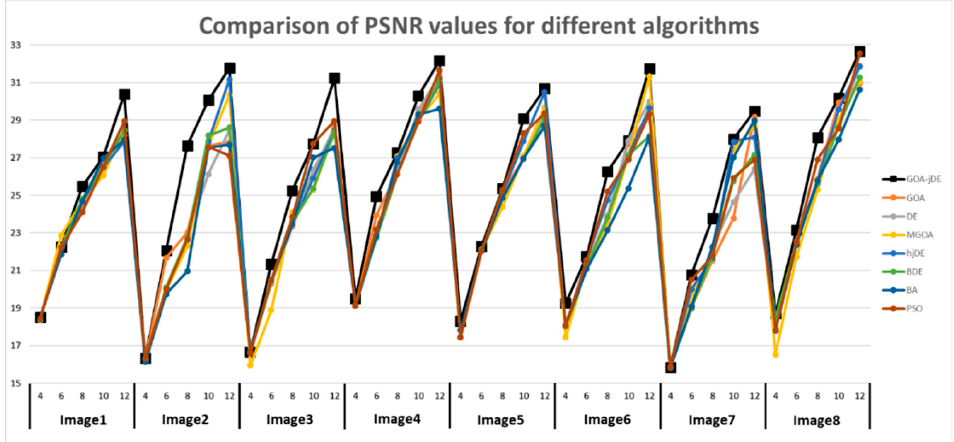
Figure 8. Comparison of PSNR values for different algorithms using MCE method at 4, 6, 8, 10, and 12 levels.